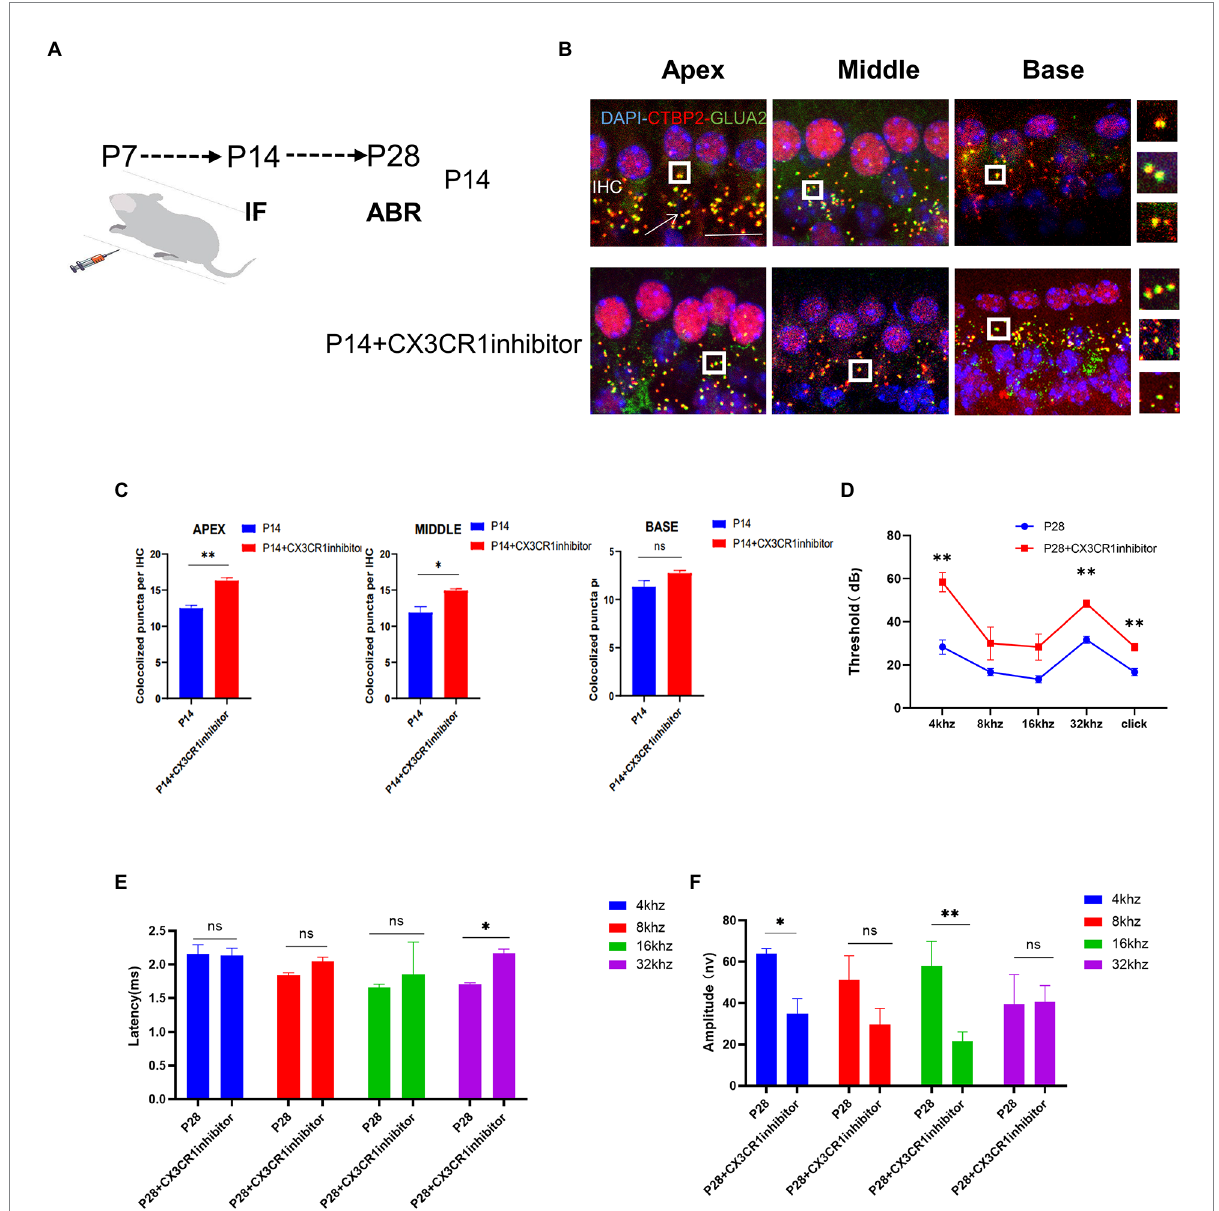
FIGURE 5 Inhibition of CX3CR1 activation in postnatal mice significantly impairs the morphological features of the ribbon synapses in cochlear IHC. (A) Mice were intraperitoneally injected with CX3CR1 inhibitor or normal saline daily starting from 7 days after birth. (B) Immunofluorescence staining of IHC ribbon synapses at P14 in each group. Presynaptic and postsynaptic proteins are co-stained; the nucleus is stained with DAPI. A magnified view of the synaptic sites is shown on the right. (C) Quantitative analysis showing that the number of synapses in the apex to the middle and bottom synapses in the cochlea is significantly higher in the CX3CR1 inhibitor-treated group than in the control group ( * p < 0.05, ** p < 0.01). Scale bar = 10 μ m, n = 3. (D–F) Quantification of ABR threshold, amplitude, and latency of ABR wave I on P14 in control mice and CX3CR1 inhibitor mice. Significant increases in ABR thresholds at 4 and 32 kHz and click frequencies are detected in treated mice and controls. The latency of ABR wave I across frequencies (32 kHz) at P14 is longer in the treated mice than in controls. The amplitude of ABR wave I across frequencies (4 and 16 kHz) at P14 is lower in treated mice than in control mice (treatment group: n = 4, control group: n = 4; * p < 0.05, ** p <